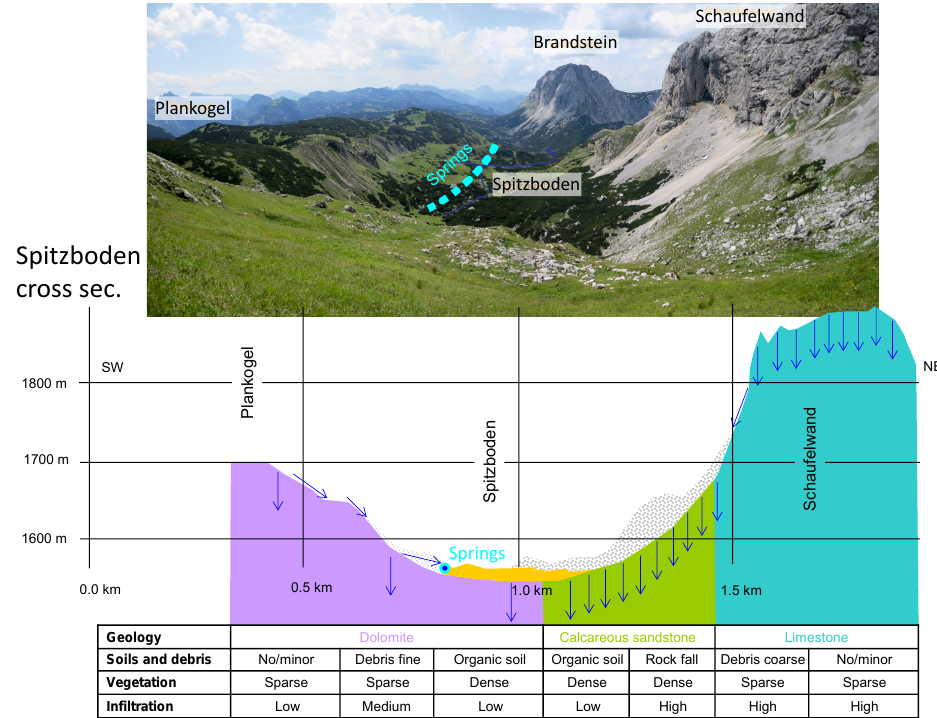
Figure 3. Cross section of the Spitzboden area illustrating the mapped properties (geology, soils and debris, vegetation, and infiltration capacity; see Table 1). Yellow and grey shading relates to organic soil layer and coarse debris from the wall in the northeast (NE), respectively. Blue arrows indicate dominant drainage directions during a typical summer storm; a higher density of arrows indicates larger